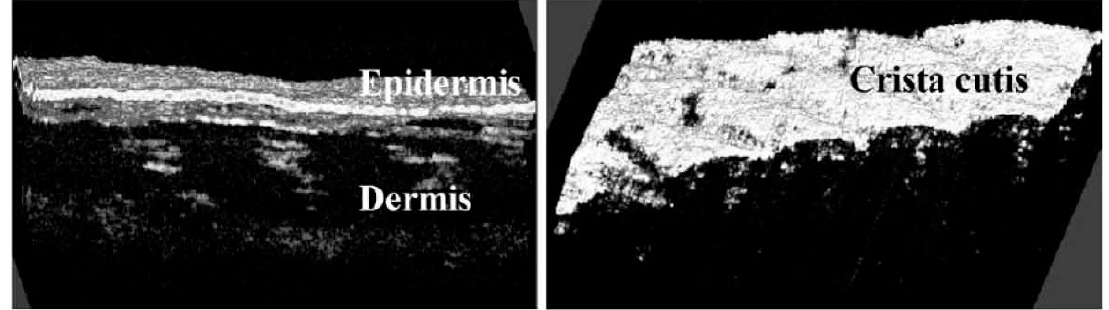
Figure 18. 3 × 3 mm 2 OCT images of human fingers: the epidermis including stratum corneum and the crista cutis (Figures from [56]).